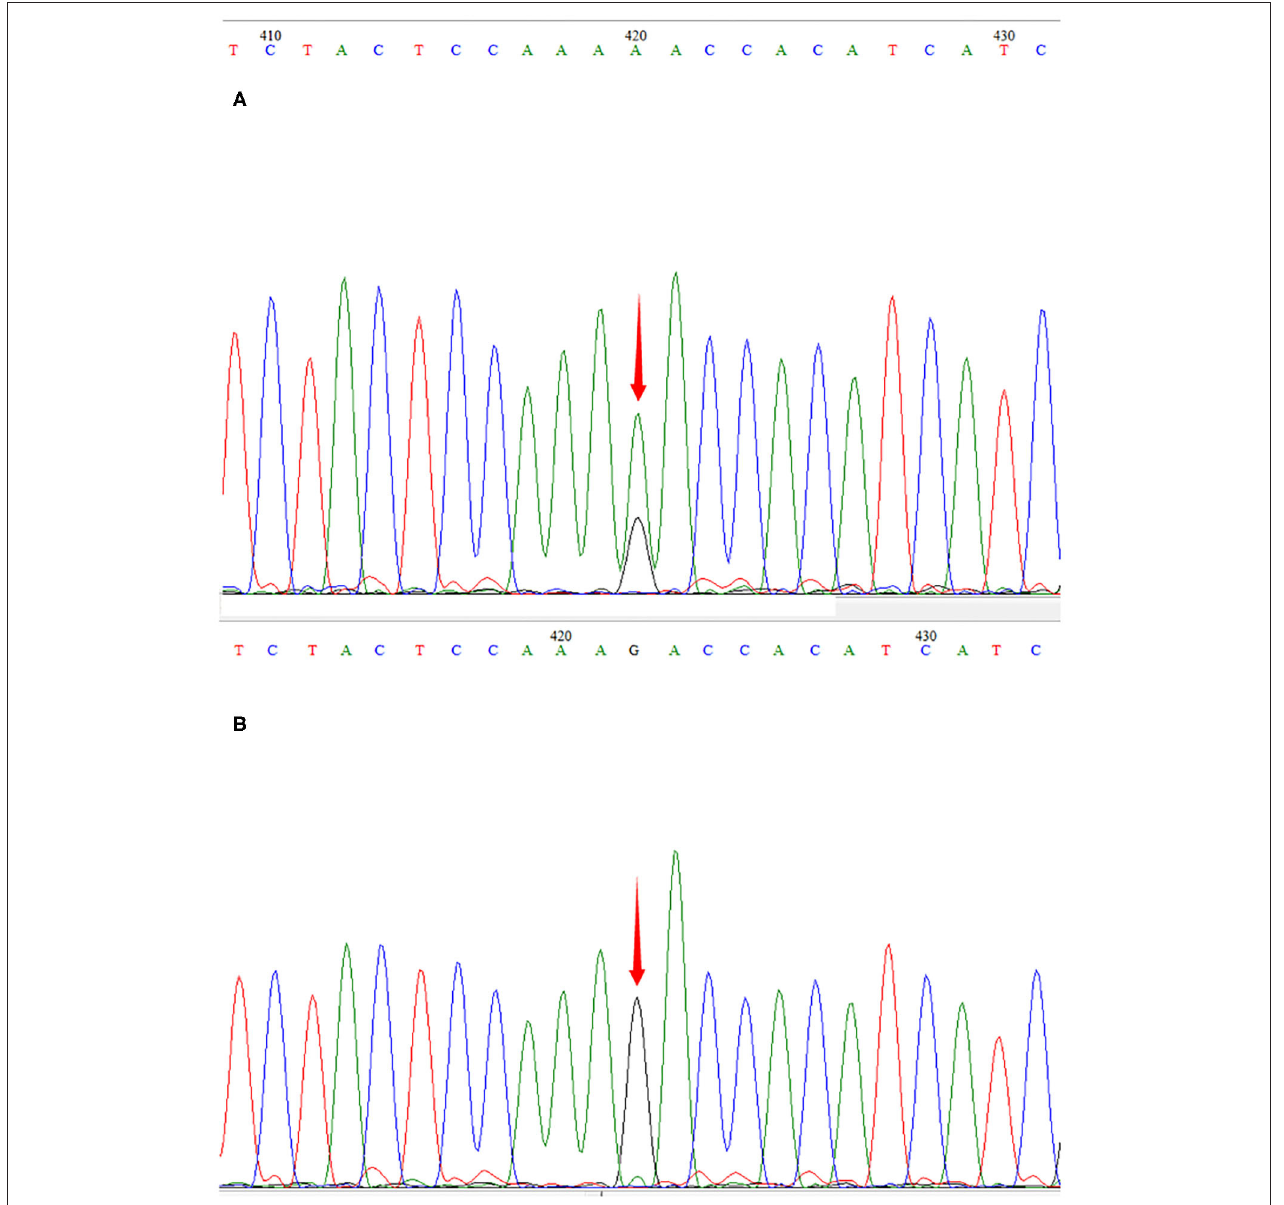
FIGURE 2 | Sequencegrams. m.13513G > A was identified in the DNA of the patient (A) . The mutation was not found in DNA samples derived from his mother (B) .